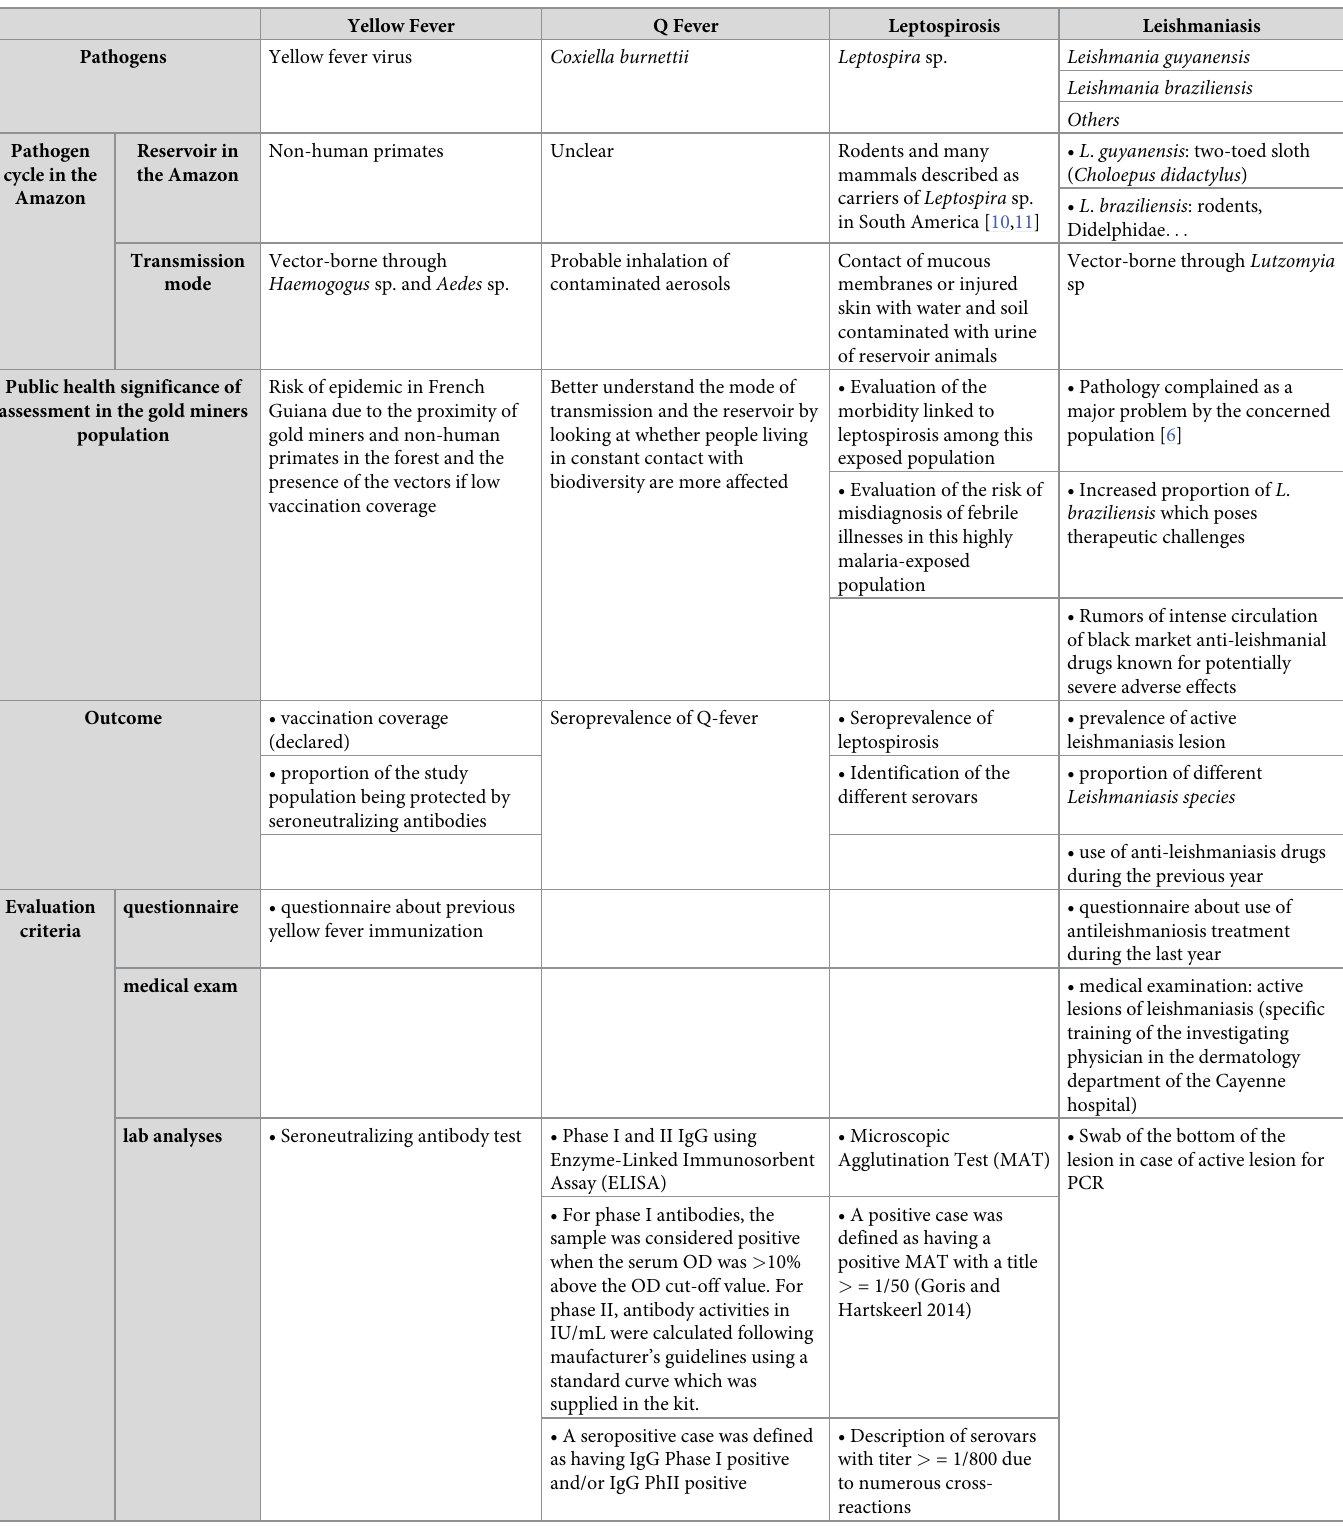
Table 1. Diseases studied with their ecology, epidemiology, public health issue in the Amazon and assessment method in this